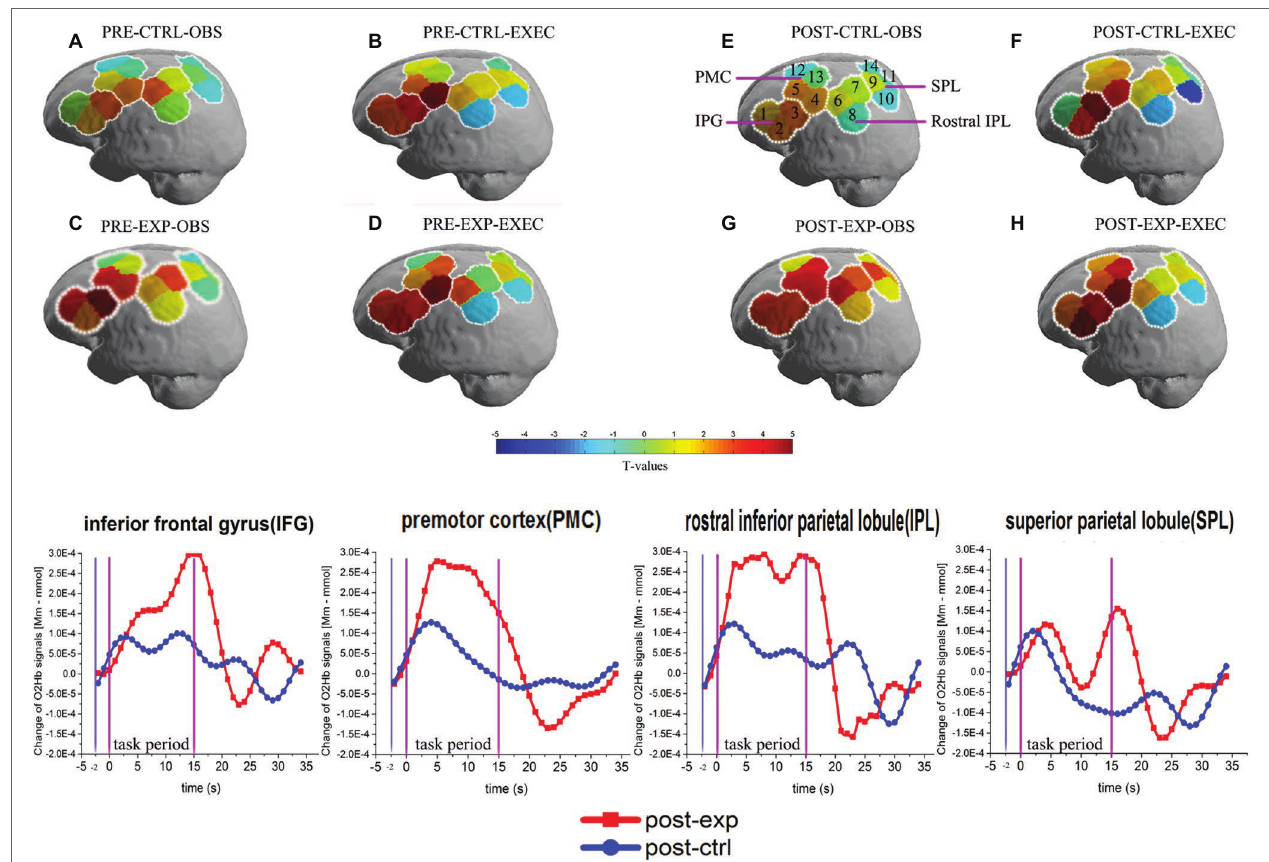
FIGURE 4 | Activation patterns of the MNS after exercise when using the ROI-based group analysis. MNS brain regions activated in the left hemisphere during action observation prior to exercise or rest (A,C) , and action execution prior to exercise or rest (B,D) , action observation following exercise or rest (E,G) , action execution following exercise or rest (F,H) . OBS, action observation; EXEC, action execution; EXP, experimental condition/exercise; CTRL, control condition/rest; PRE, prior to EXP/CTRL; POST, following EXP/CTRL. Each small circle in the different colors represents one channel, and the color scale represents the t-values at the group level. Each white circle represents an ROI, namely the IFG (BA44/45), PMC (BA6), rostral IPL (BA40), and SPL (BA7). Representative graphs of the OxyHb signal change over time are shown in the bottom row of the figure, comparing action observation in the post-exp (red line) and post-ctrl (blue line) conditions in the four ROIs. OxyHb signals are shown in arbitrary units (mM mm). Baseline OxyHb level (2 s before task onset, denoted by the first two vertical lines) is also